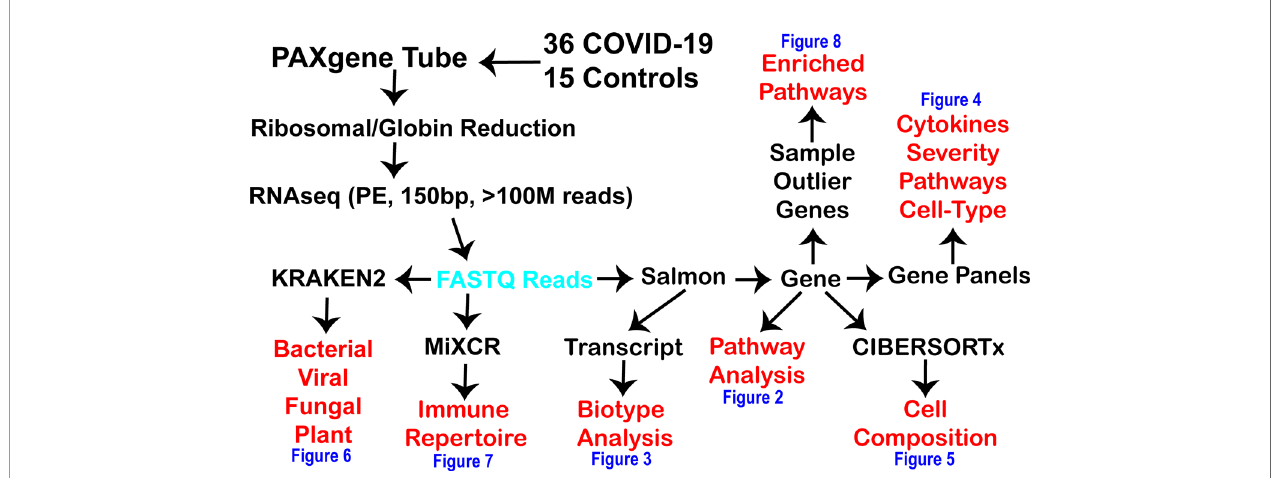
FIGURE 1 | Work fl ow for precision high-density transcriptomics used within the current study. The black text is the various steps used within the current study to generate and process fastq reads (cyan) for multiple levels of insights (red) shown within the various fi gures of the paper (blue). RNAseq was done in paired-end (PE) with 150 basepair (bp) reads with at least one hundred million reads generated per